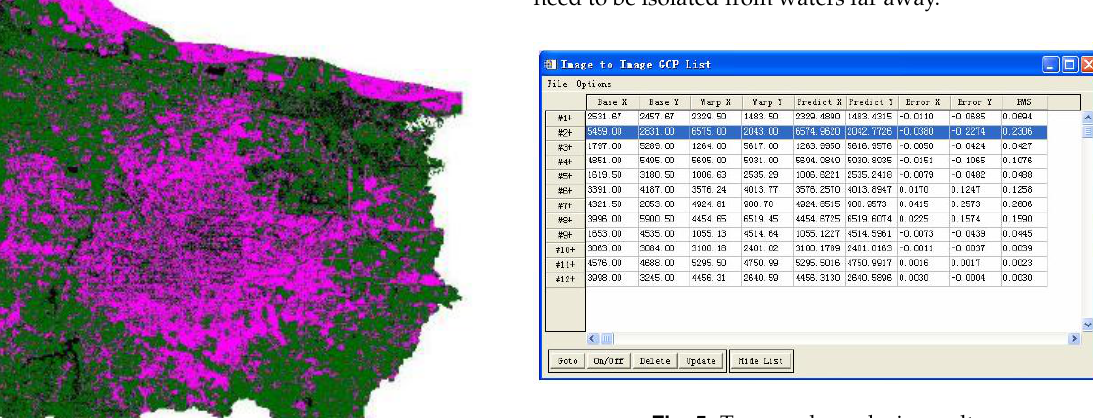
Fig. 5. Two-mode analysis